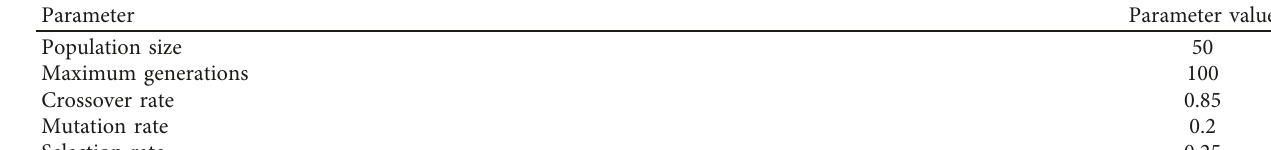
Table 8: NSGA-II controlled parameters.